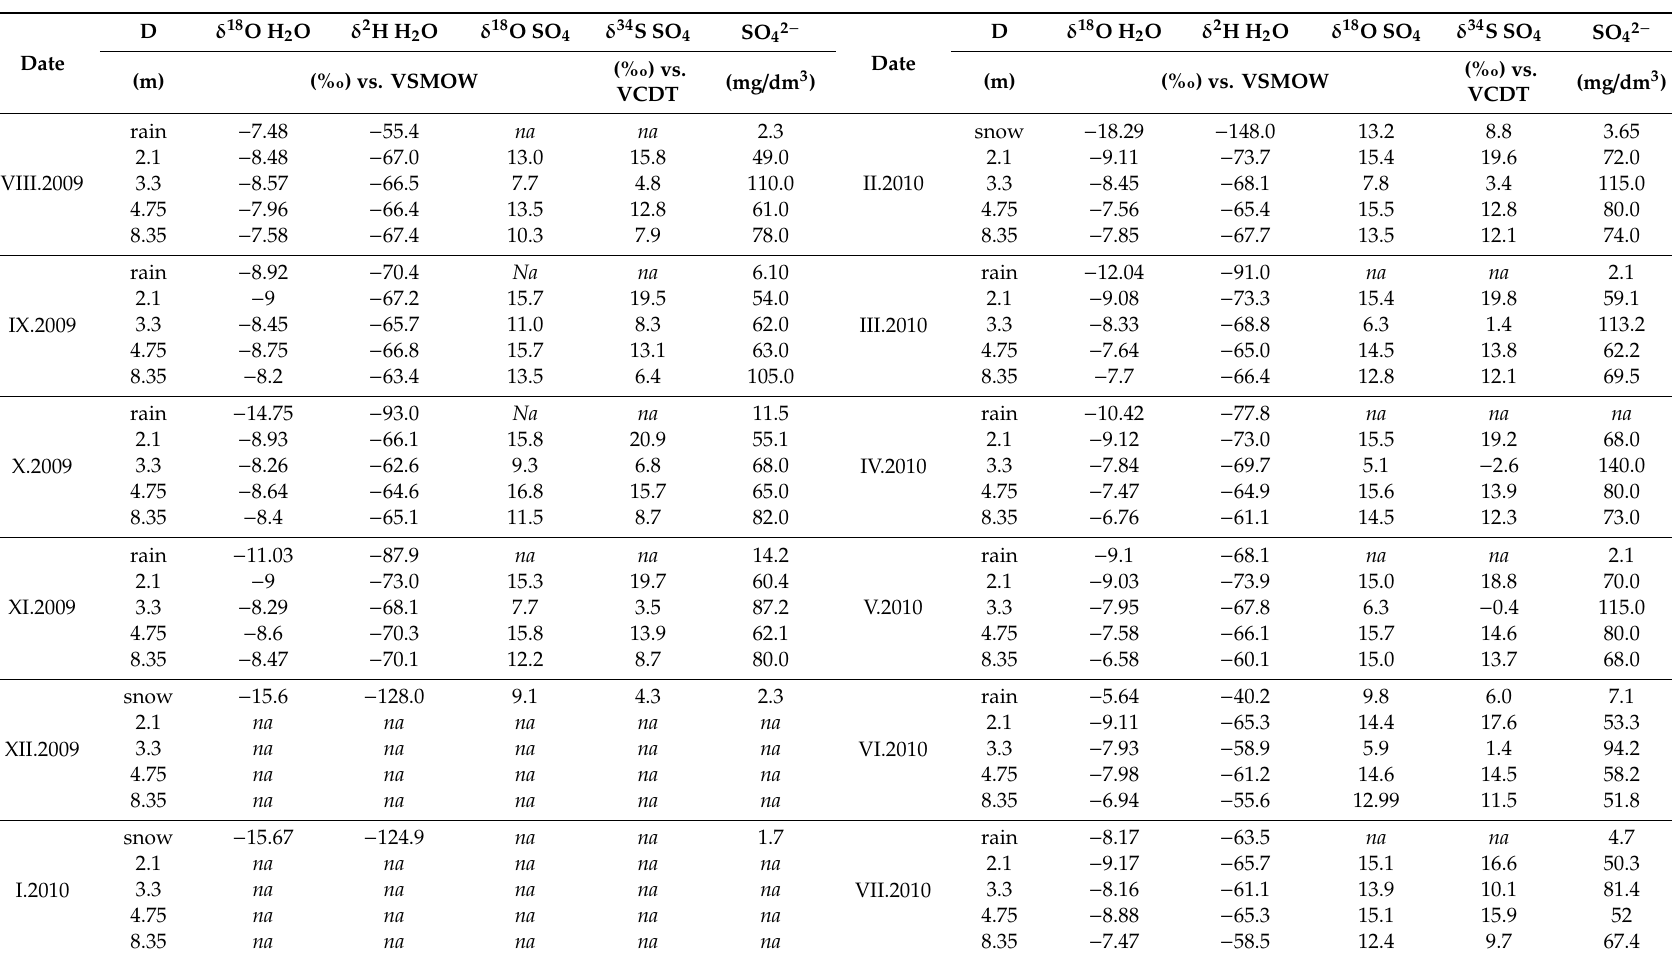
Table 2. The isotopic composition of groundwater and dissolved sulfates in the Po˙zary aquifer at monitored depths throughout the observation period. na —not